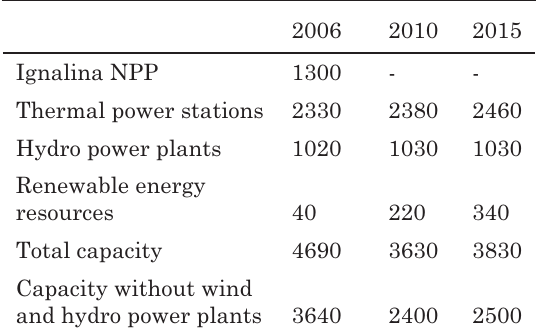
Table 1. Forecast of capacities of Lithuanian power plants,